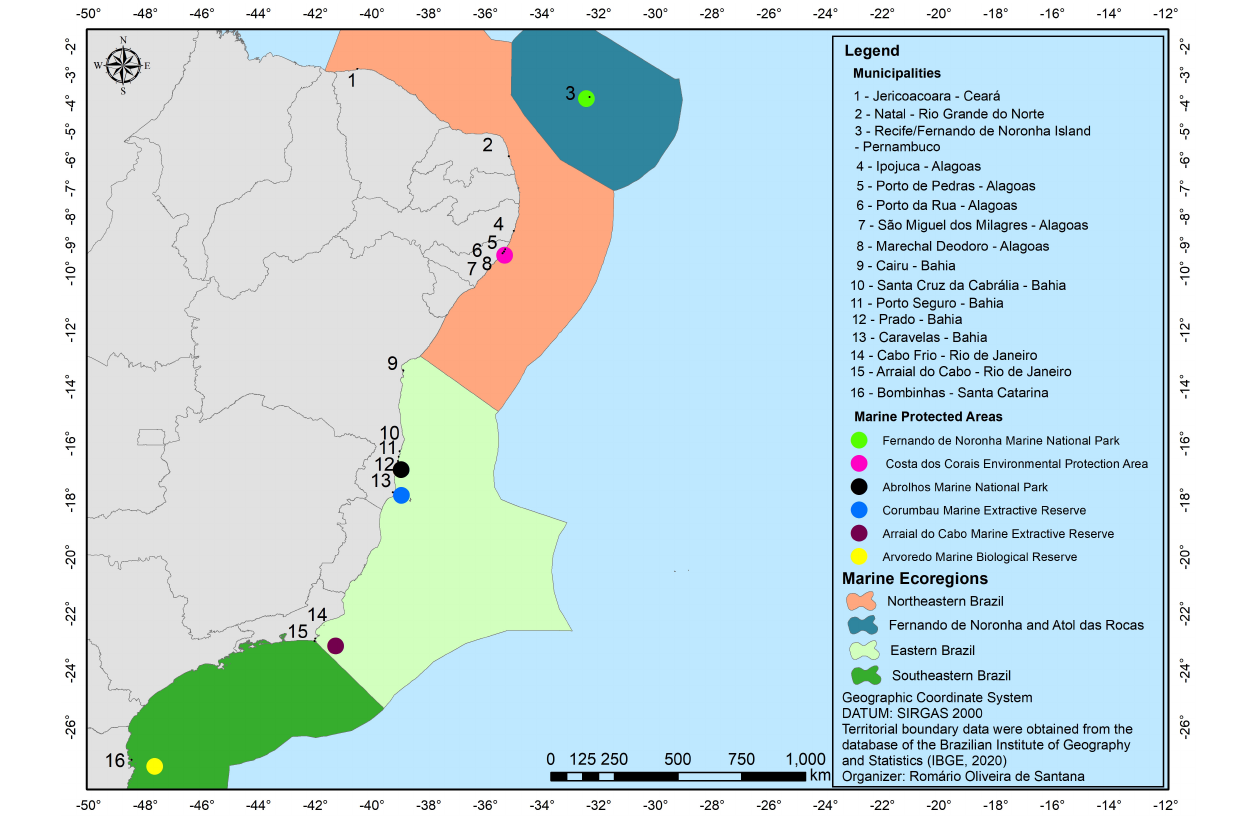
Frontiers in Ecology and Evolution |